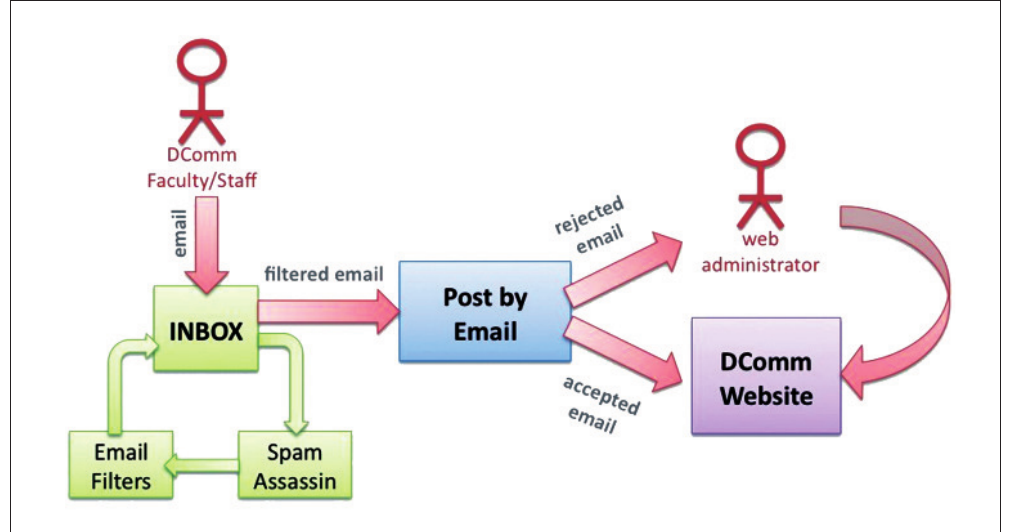
Figure 3 Proposed process of email content filtering and